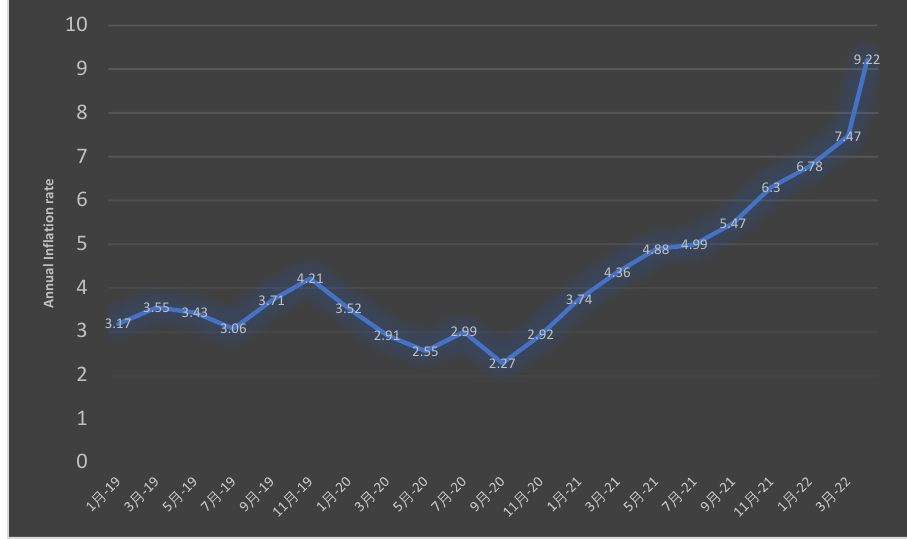
Figure 5. Global average inflation rate: Source: Authors Data from Statista.